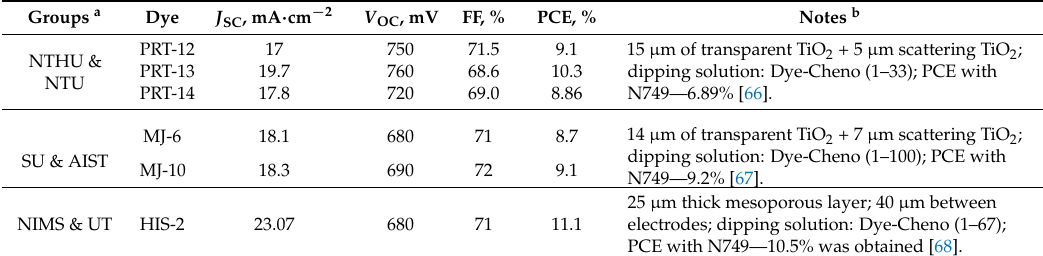
Figure 8. Black dye, and two popular directions to modify tridentate ligand. ( A , B ) represent two different ways to modify the N749. Table 2. Performance of selected ruthenium complexes with tridentate accepting ligand and three isothiocyanate donating ligands.